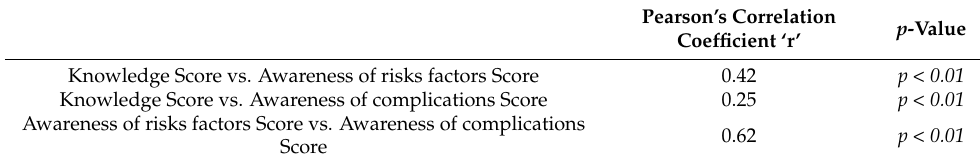
Table 4. Correlation between different scores.